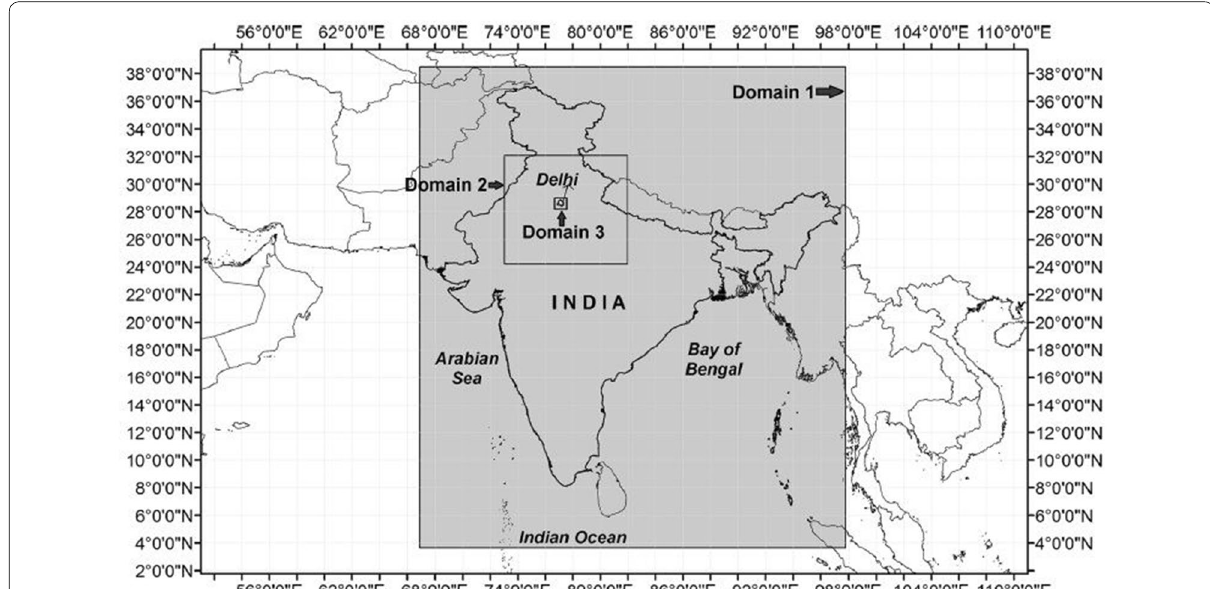
Fig. 1 Model domains (Bhati and Mohan